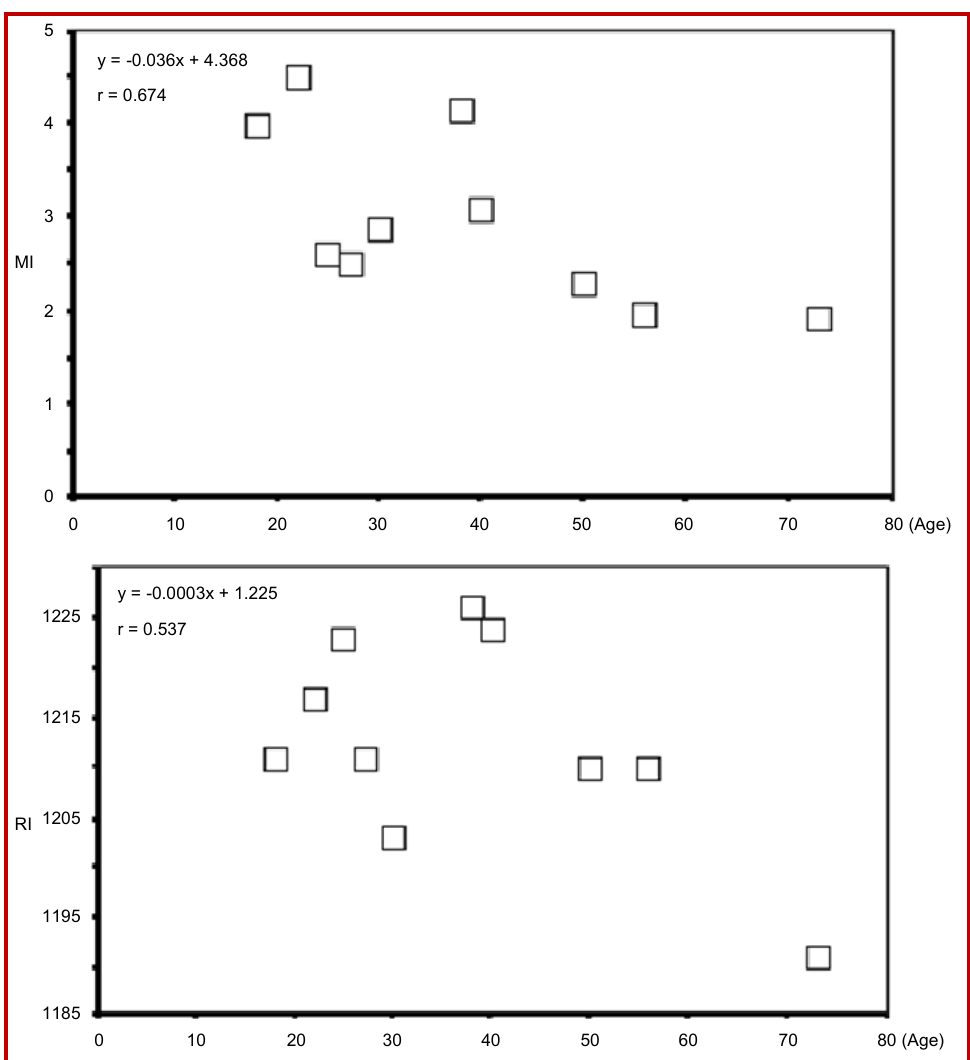
Figure 2: The positive correlation between mitotic index and replication index